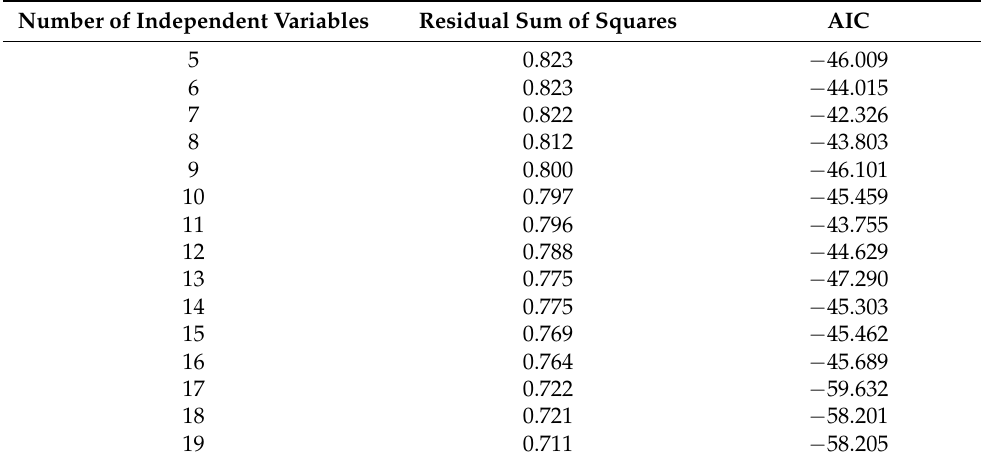
Table 4. AIC values of PLSR with different numbers of independent variables. Number of Independent